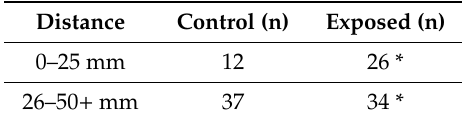
Table 2. Comparison of elicited movement in 72 hpf hatched zebrafish embryos reared in control medium and medium containing 0.5 mg/L nickel + 0.15 mg/L cadmium.